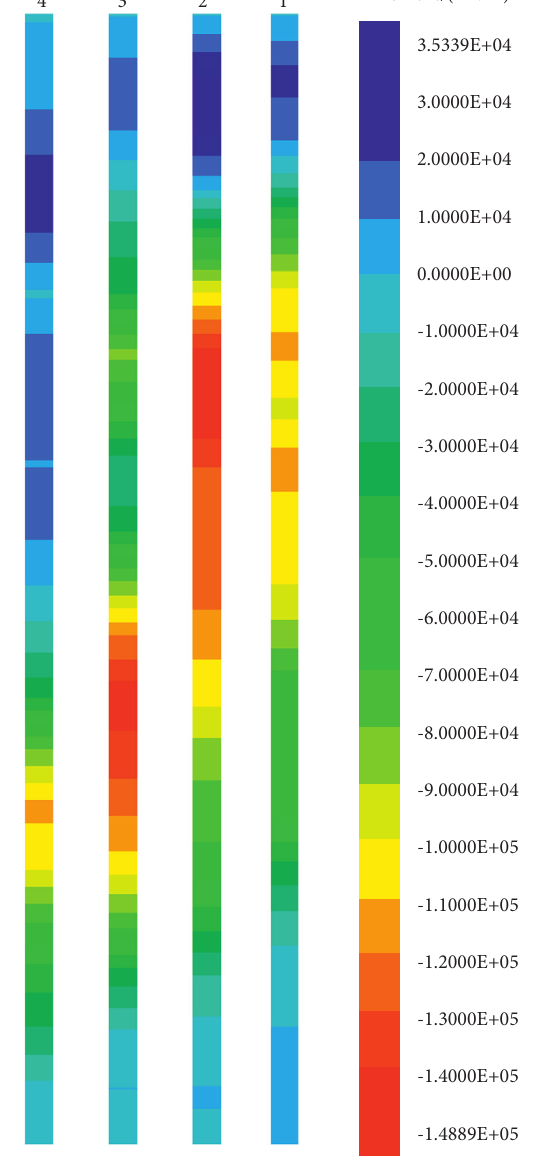
Figure 16: Cloud diagram of bending moment of bridge pile foundation.